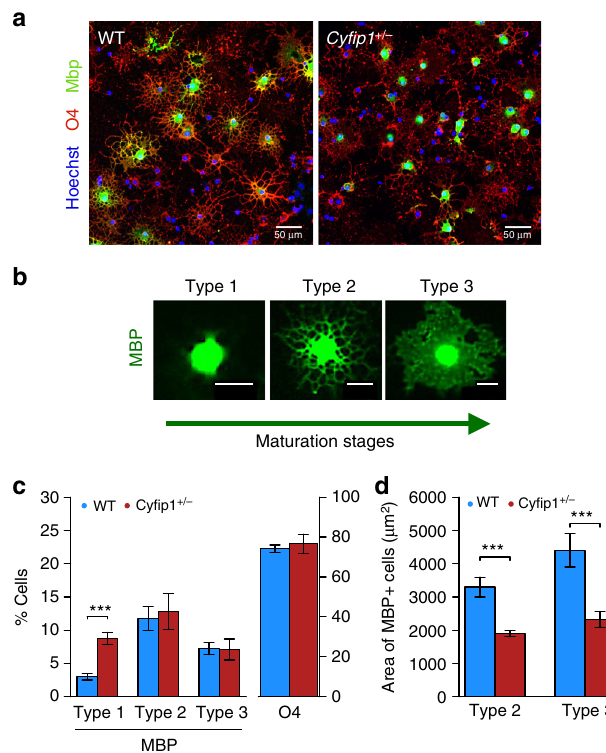
Fig. 4 Cy fi p1 haploinsuf fi ciency in fl uences the intracellular distribution of myelin basic protein (MBP) in cultured oligodendrocytes. a Immunostaining of oligodendrocytes for MBP and O4 from wild type (WT) and Cy fi p1 + / − , scale bar = 50 μ m, illustrating the punctate intracellular pattern of staining of MBP in Cy fi p1 + / − relative to the more diffused, widespread pattern of staining in WT. b Representative images of oligodendrocytes staining for MBP exhibiting features of Type 1 (MBP localised to the cell body), Type 2 (MBP ramifying into the cell processes), Type 3 (MBP distributed throughout the cell and within the membranes of cell processes) re fl ecting increasing maturation stages of oligodendrocytes, scale bar = 20 μ m. c the effects of genotype on the percentage of Type 1 ( n = 172 WT and 637 Cy fi p1 + / − cells; LME: χ 2 (1) = 68.49, ***), Type 2 ( n = 735 WT and 905 Cy fi p1 + / − cells, LME: χ 2 (1) = 0.59, p = 0.44), Type 3 ( n = 456 WT and 454 Cy fi p1 + / − cells; LME: χ 2 (1) = 0.02, p = 0.88), and O4 + cells ( n = 4917 WT and 5789 Cy fi p1 + / − cells; LME: χ 2 (1) = 1.44, p = 0.23), as a proportion of all cells Hoechst); this panel also illustrates the effects of genotype on the overall proportion of differentiating oligodendrocytes as indexed by all cells staining for O4. d effects of genotype on the area of intracellular MBP staining in Type 2 ( n = 491 WT and 591 Cy fi p1 + / − cells; LME: χ 2 (1) = 258.03, ***) and Type 3 ( n = 265 WT and 341 Cy fi p1 + / − cells; LME: χ 2 (1) = 145.52, ***) oligodendrocytes, as depicted in the representative images in b. Values were obtained from 3 independent experiments.